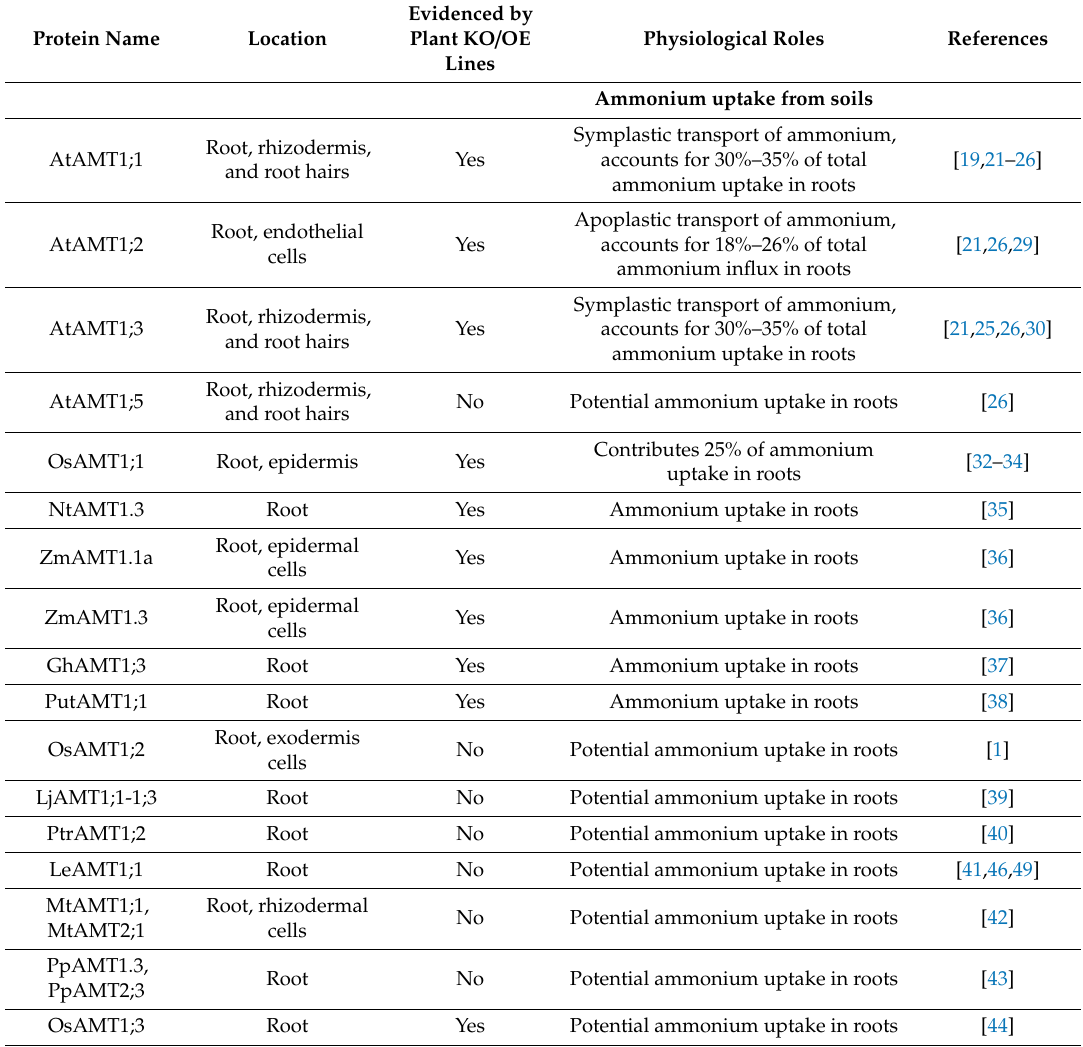
Table 1. Physiological roles of ammonium transporters (AMTs) in